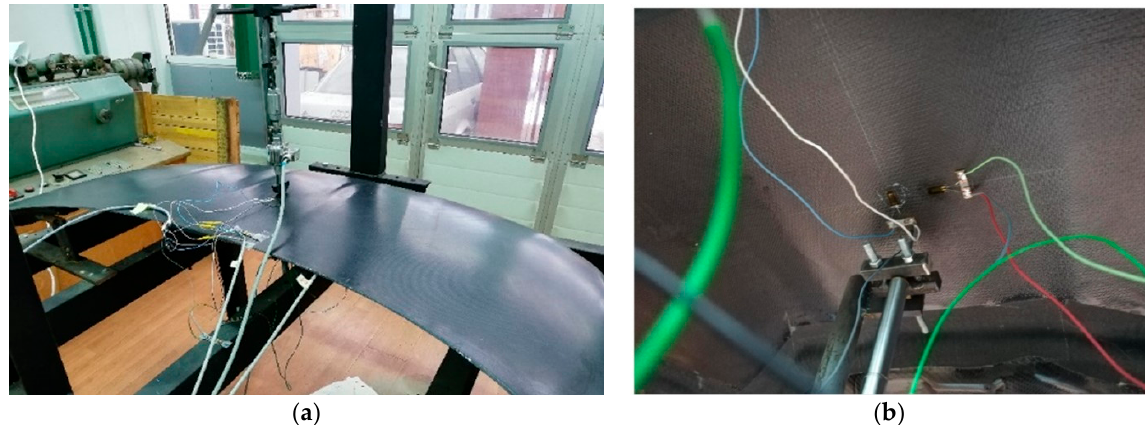
Figure 15. Experimental set-up for structural analyses of the composite hood “B”: ( a ) load position for lateral stiffness evaluation and ( b ) strain gauges applied in longitudinal and transversal direction on the lower face.